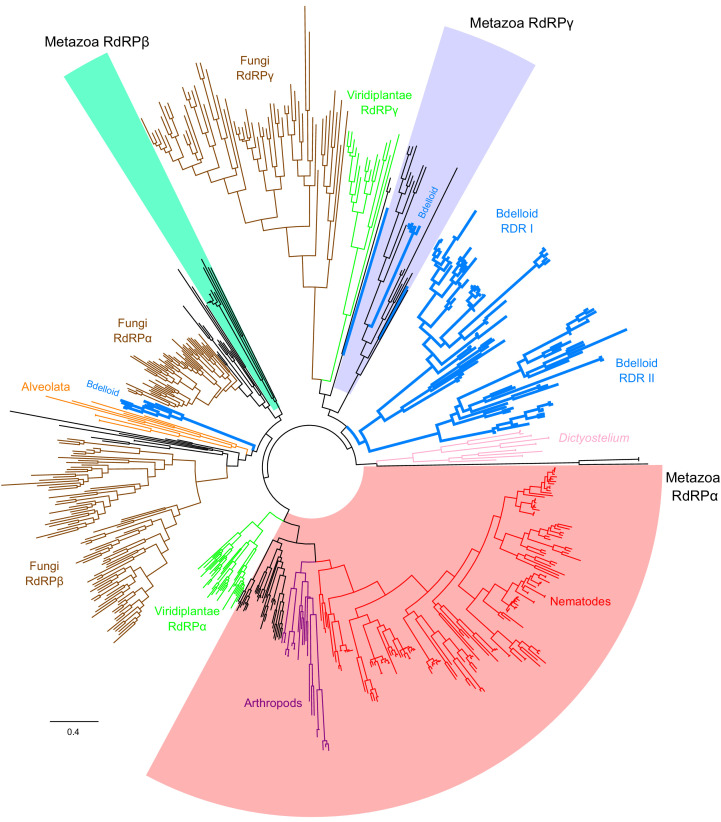
Extended RdRP phylogeny.The core alignment and clade annotations are from Pinzón et al., 2019 with bdelloid copies from three species A. steineri, R. sordida, and R. sp. ‘Silwood-1’ 10x haploid assemblies inserted using HMMER ‘hmmalign’. Bdelloid copies are indicated on the tree with thicker branches coloured blue. The metazoan clades of RdRPα, β, and γ are shaded with red, green, and blue, respectively. Note that the large diversity of nematode RdRPs (red branches) is mostly due to extensive taxon sampling from within the nematodes (58 species); in contrast, the bdelloid copies are sampled from three species. Scale bar indicates 0.4 amino acid substitutions per site.